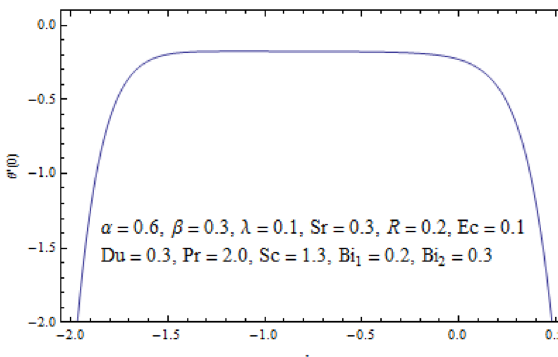
Fig. 2 (cid:2) θ − curve for temperature field